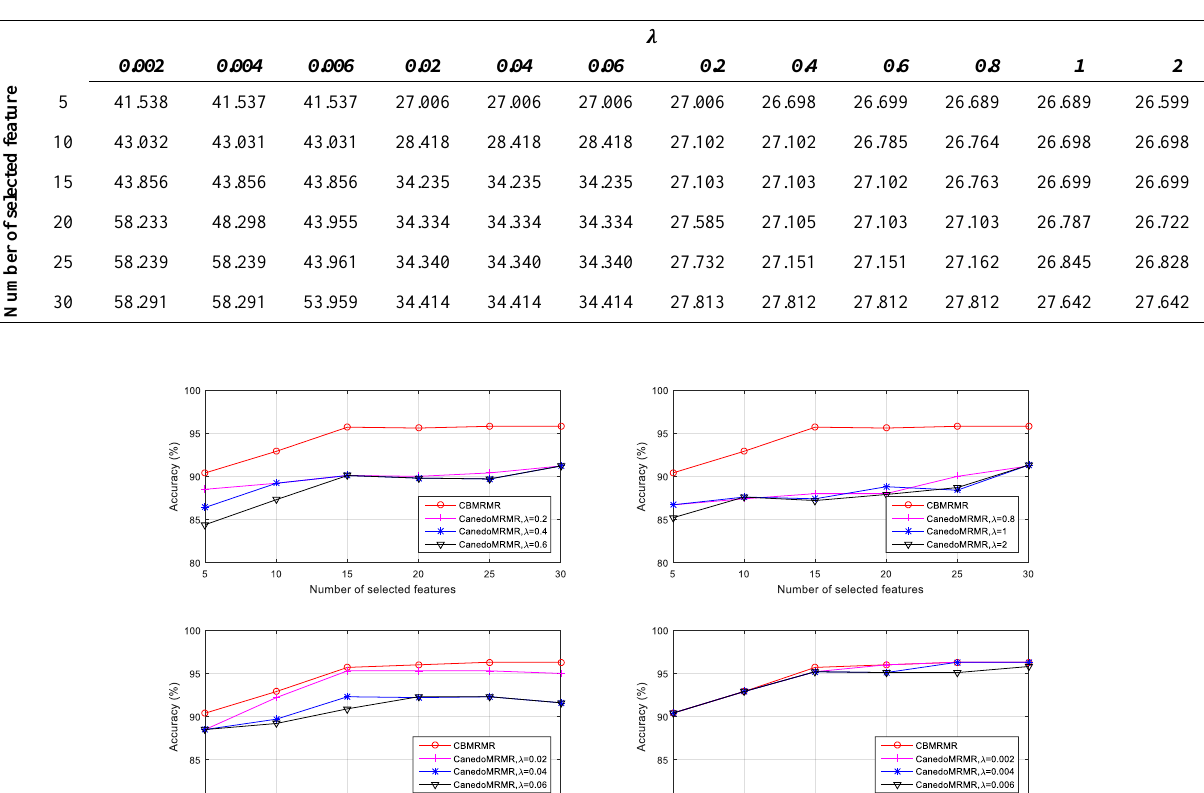
Table 3. Detection time of a webpage with different  in ms.